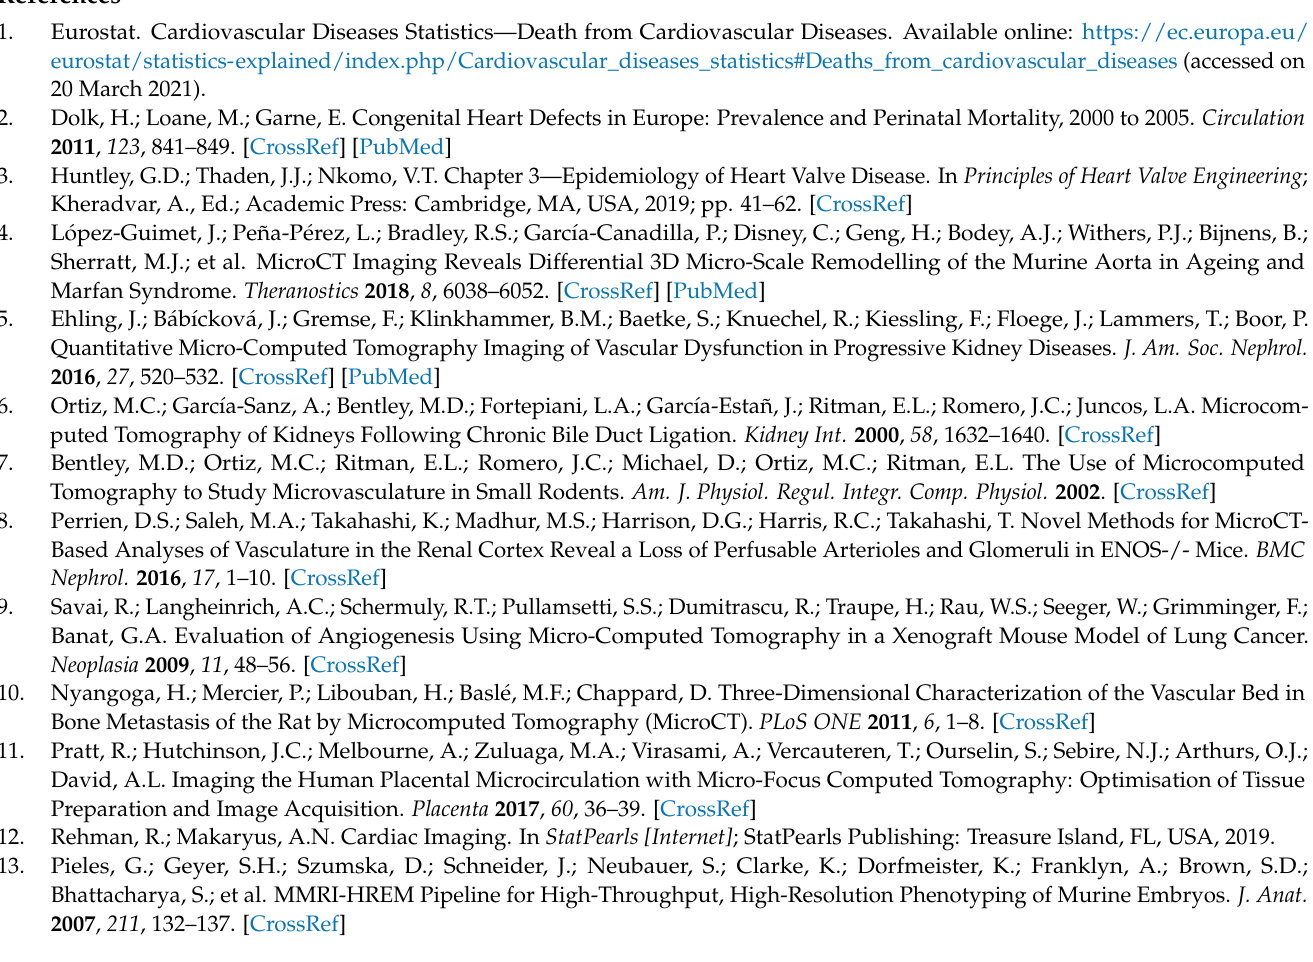
Fischer Scientific). Figure 7. A piece of the abdominal rat aorta was collected and fixed in 4% formaldehyde for for 48 h. It was then scanned with a Phoenix Nanotom M (GE Measurement and Control voxel size of 1.1 µ m, averaging 3, skip 1 and an exposure time of 500 ms. An ROI was selected and was then segmented manually based on grayscale values using Avizo software (Thermo Fischer